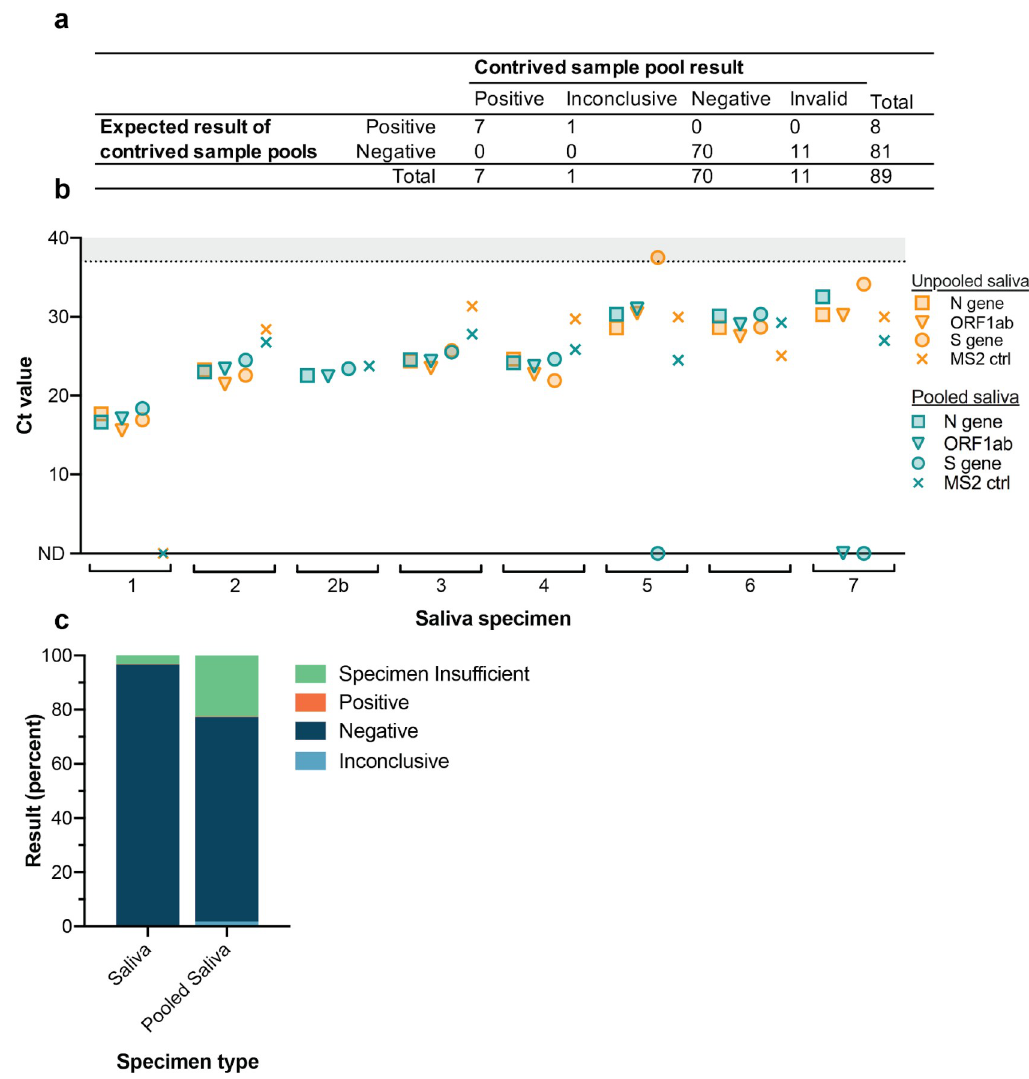
Fig 4. Four-plex pooling of saliva specimens. Four-plex pools were generated with saliva samples previously determined to be positive or negative for the presence of SARS-CoV-2 RNA. 81 wells were generated to contain four negative samples and eight contained one positive sample mixed with 3 negative samples. a, All wells containing positive sample pools were called either positive (7/8) or inconclusive (1/8). b, Viral and MS2 Ct values for unpooled and pooled positive saliva samples. Note that unpooled saliva sample 2 was run in two separate positive pools while all other positive pools contained unique positive samples. Samples were sorted by the N gene Ct value in unpooled saliva samples. Ct values > 37 are shaded in gray. Undetected Ct values are plotted as zero and designated by “ND”, not detected. c, Results of pooled samples are compared to the final results for unpooled saliva samples run on the finalized saliva extraction protocol. “Specimen Insufficient” pooled samples were subsequently re-run either in new pools or unpooled to obtain a final